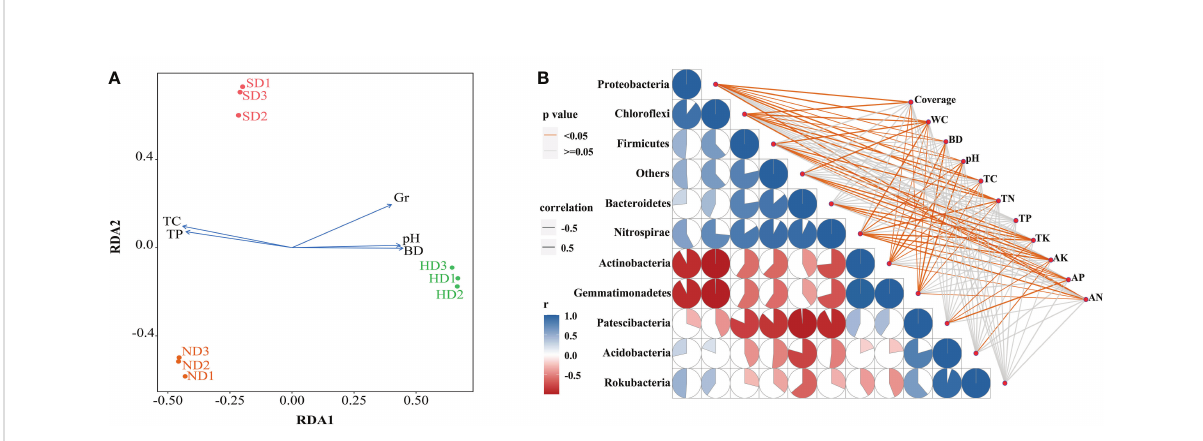
FIGURE 7 Correlation analysis between the bacterial community structure and environmental factors in the non-degraded (ND), slightly degraded (SD), and heavily degraded (HD) alpine wetland areas. (A) Distance-based redundancy analysis (db-RDA) of the soil bacterial community with environmental factors. (B) Spearman correlation analysis between the dominant bacteria phyla and environmental factors. Pairwise comparisons of the environmental factors are shown with a color gradient denoting the Spearman correlation coef fi cient. Taxonomic bacteria (based on the phylum level) community composition is related to each environmental factor by partial (geographic distance-corrected) Mantel tests. The edge width corresponds to the Mantel ’ s r statistic for the corresponding distance correlations. The edge color denotes the statistical signi fi cance based on 9,999 permutations. Note: n = 3. Coverage: total plan coverage; SM: soil moisture content; BD: bulk density; TC: total carbon; TN: total nitrogen; TP: total phosphorus; TK: total potassium; AK: available potassium; AP: available phosphorus; AN: available